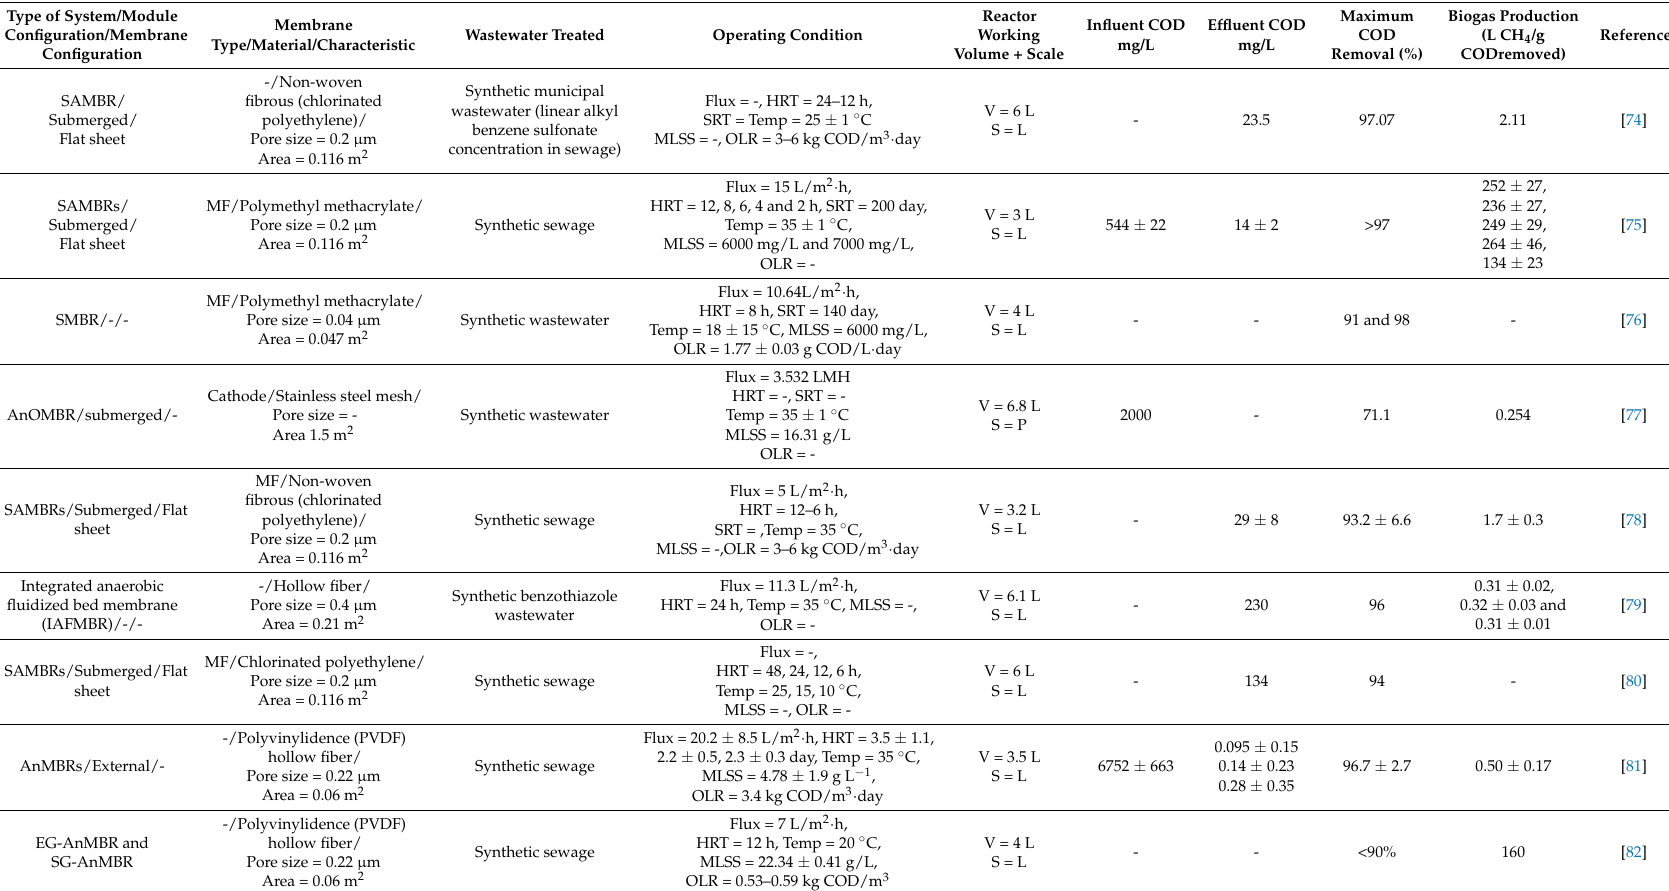
Table 4. References on anaerobic membrane bioreactors for synthetic wastewater